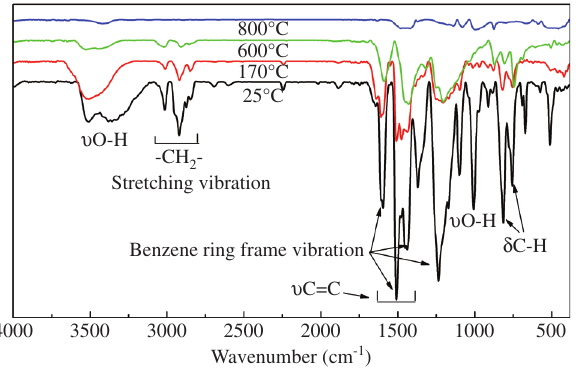
Figure 4 FTIR spectrogram of phenolic resin at different